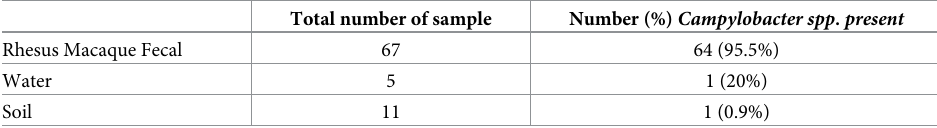
Table 1. Campylobacter in fecal samples of rhesus macaque, soil and water from two sites in